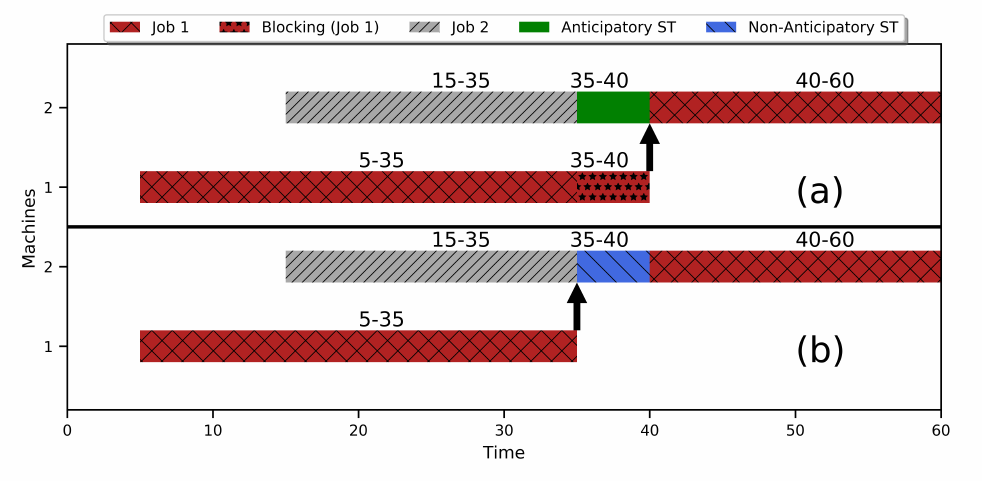
Figure 3. The effects of anticipatory ( a ) and nonanticipatory ( b ) setups on the schedule.